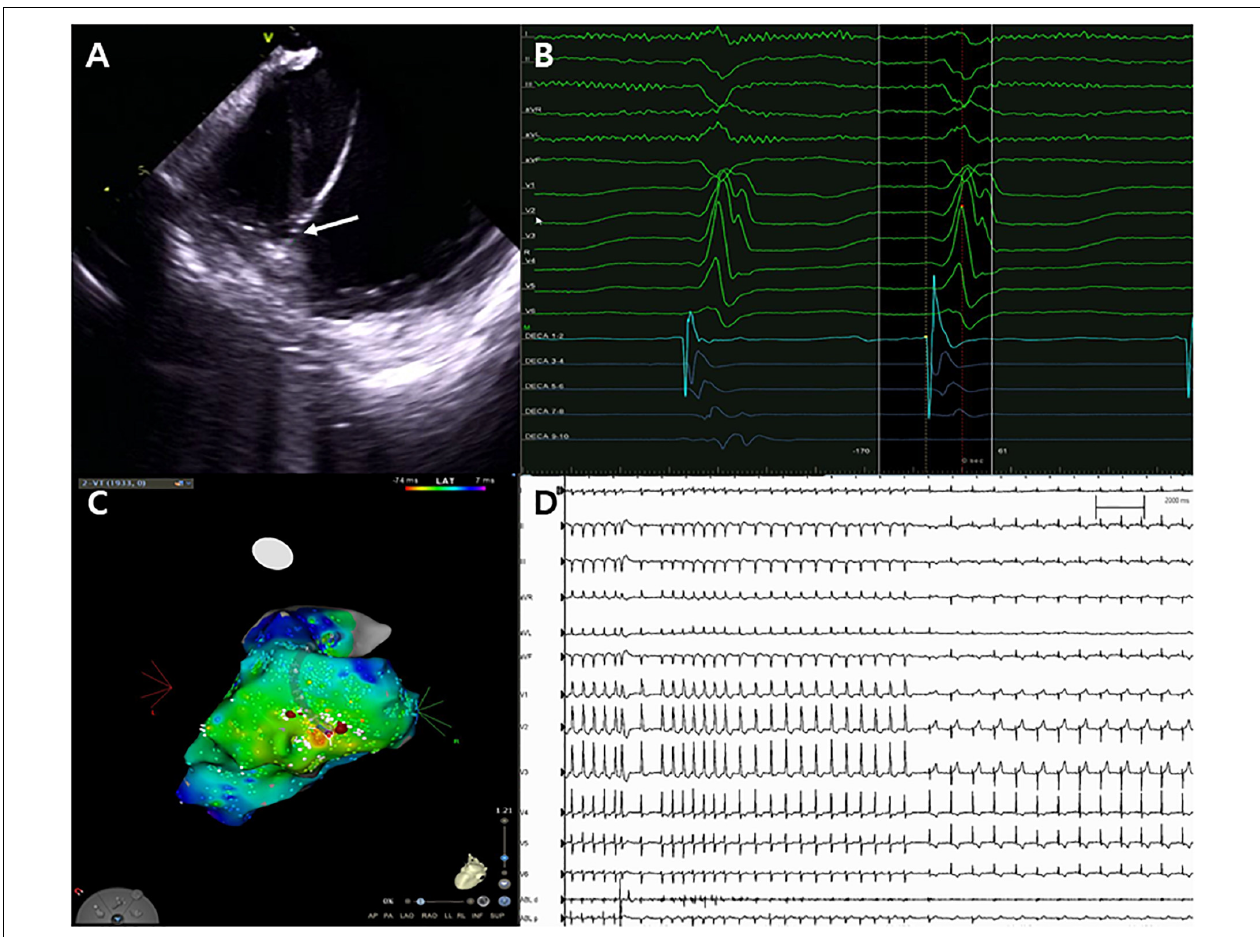
FIGURE 2 | Catheter ablation for ventricular tachycardia. (A) Successful ablation site on the left posteromedial papillary muscle (white arrow). (B,C) Unipolar Q signal on successful ablation site and three-dimensional activation map. (D) Termination of ventricular tachycardia with steam